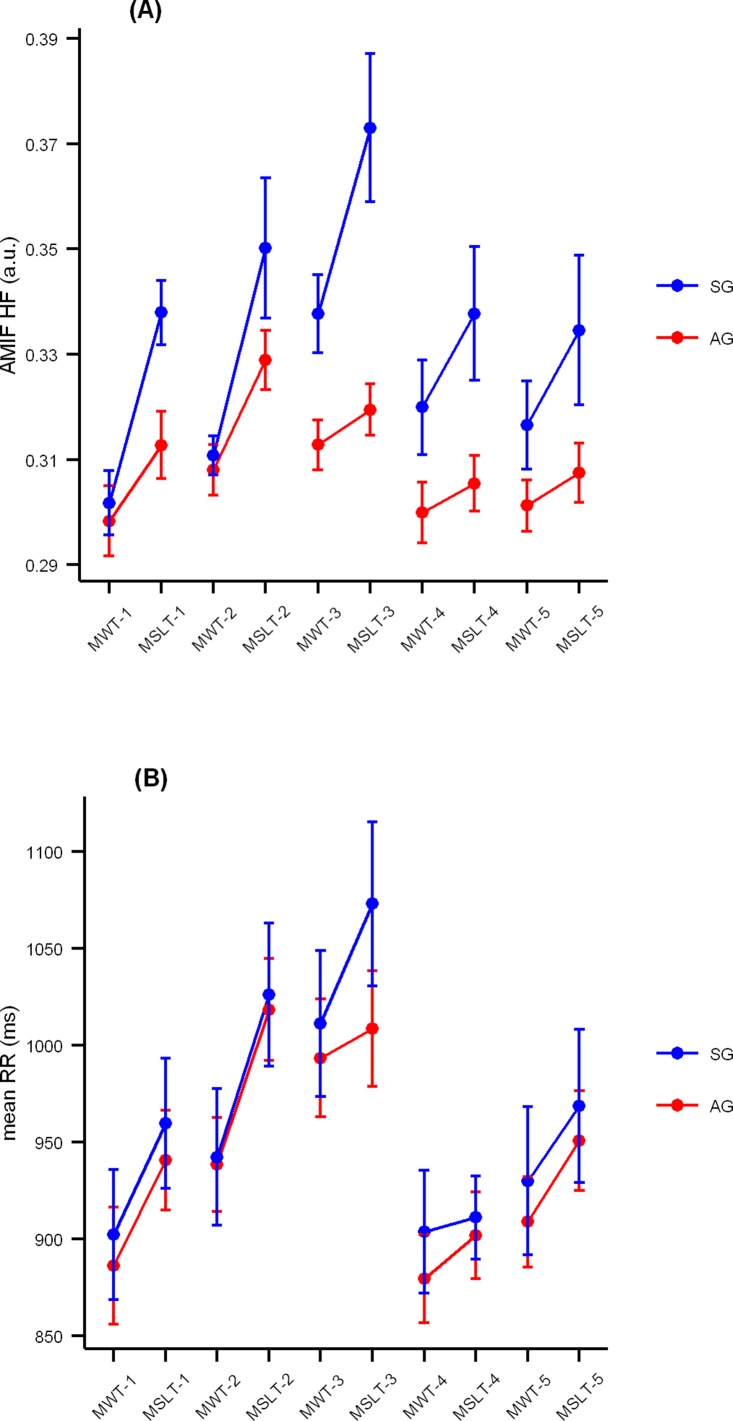
Representation of AMIF-HF and mean RR interval throughout the 5 blocks of MWT and MSLT.Sleepy group, in blue, alert group, in red. Point and error bars represent mean ± standart errors. In graphic (A), SG shows an increased regularity of RR rhythm during almost all nap tests in comparison to AG, especially at the MSLT. Within each group, however, there is a type of nap test effect, with increased values at the MSLT in comparison to MWT. In graphic (B), both groups show a reliably longer mean RR interval (i.e. slower heart rate) during MSLT as compared to MWT, but there are no differences between groups in any test. The lowest values of all naps are seen during the 1st and 4th block, after breakfast and lunch time. Abbreviations: SG, sleepy group; AG, alert group; AMIF-HF, Auto-mutual information function in high frequency band; mean RR, mean RR interval; MWT, maintenance of wakefulness test; MSLT, multiple sleep latency test.